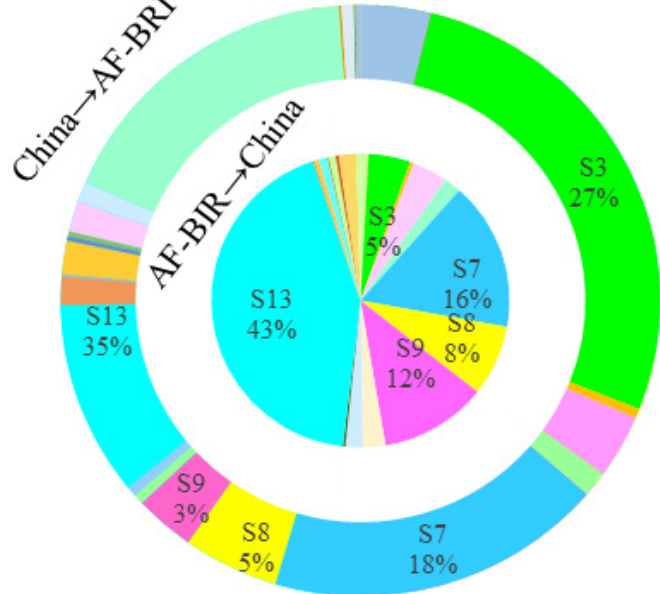
Figure 6. Sectoral CSE between China and AF-BRI.